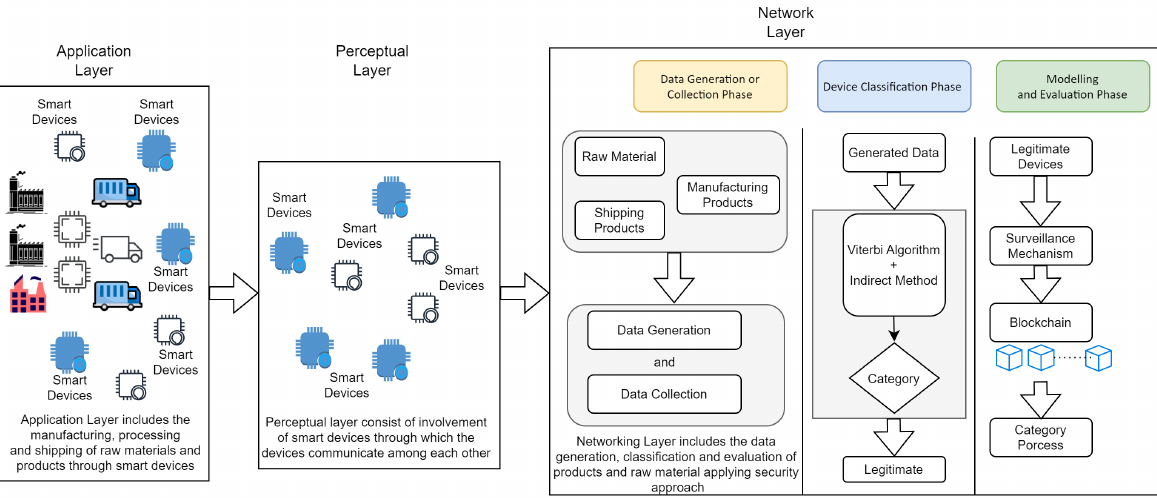
Figure 1. Typical Architecture of an IIoT